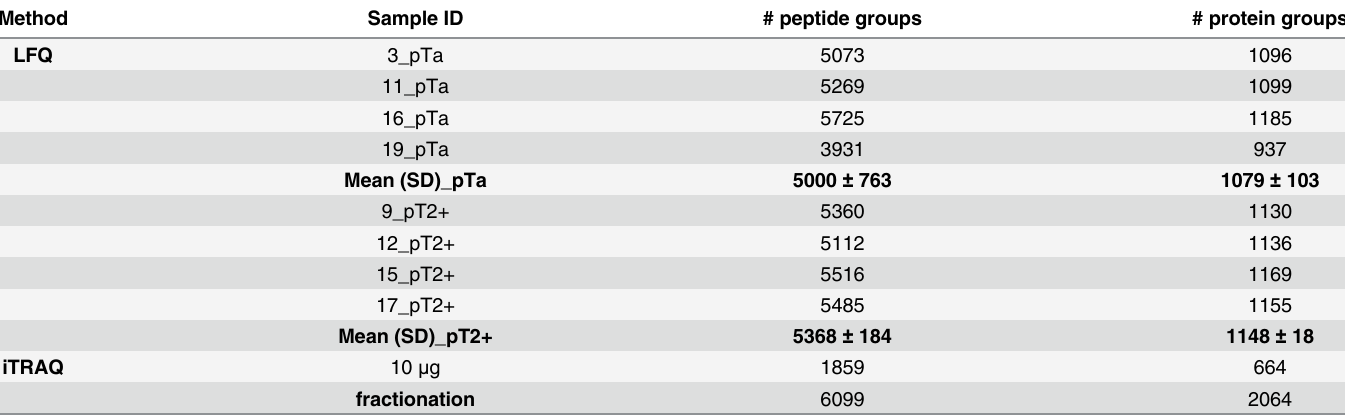
Table 1. Overview of the number of peptides and the corresponding proteins as being identified in the individual